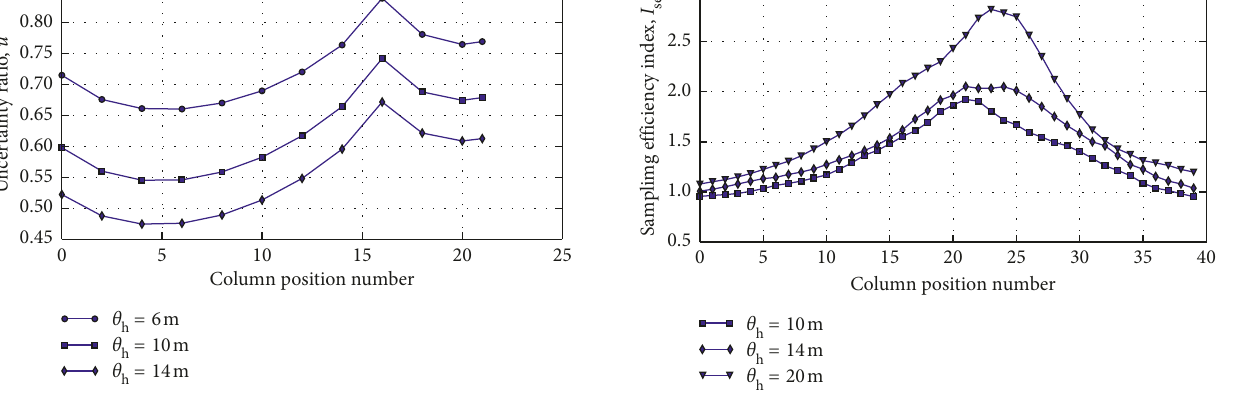
(1 CPT sampling), example 2. h